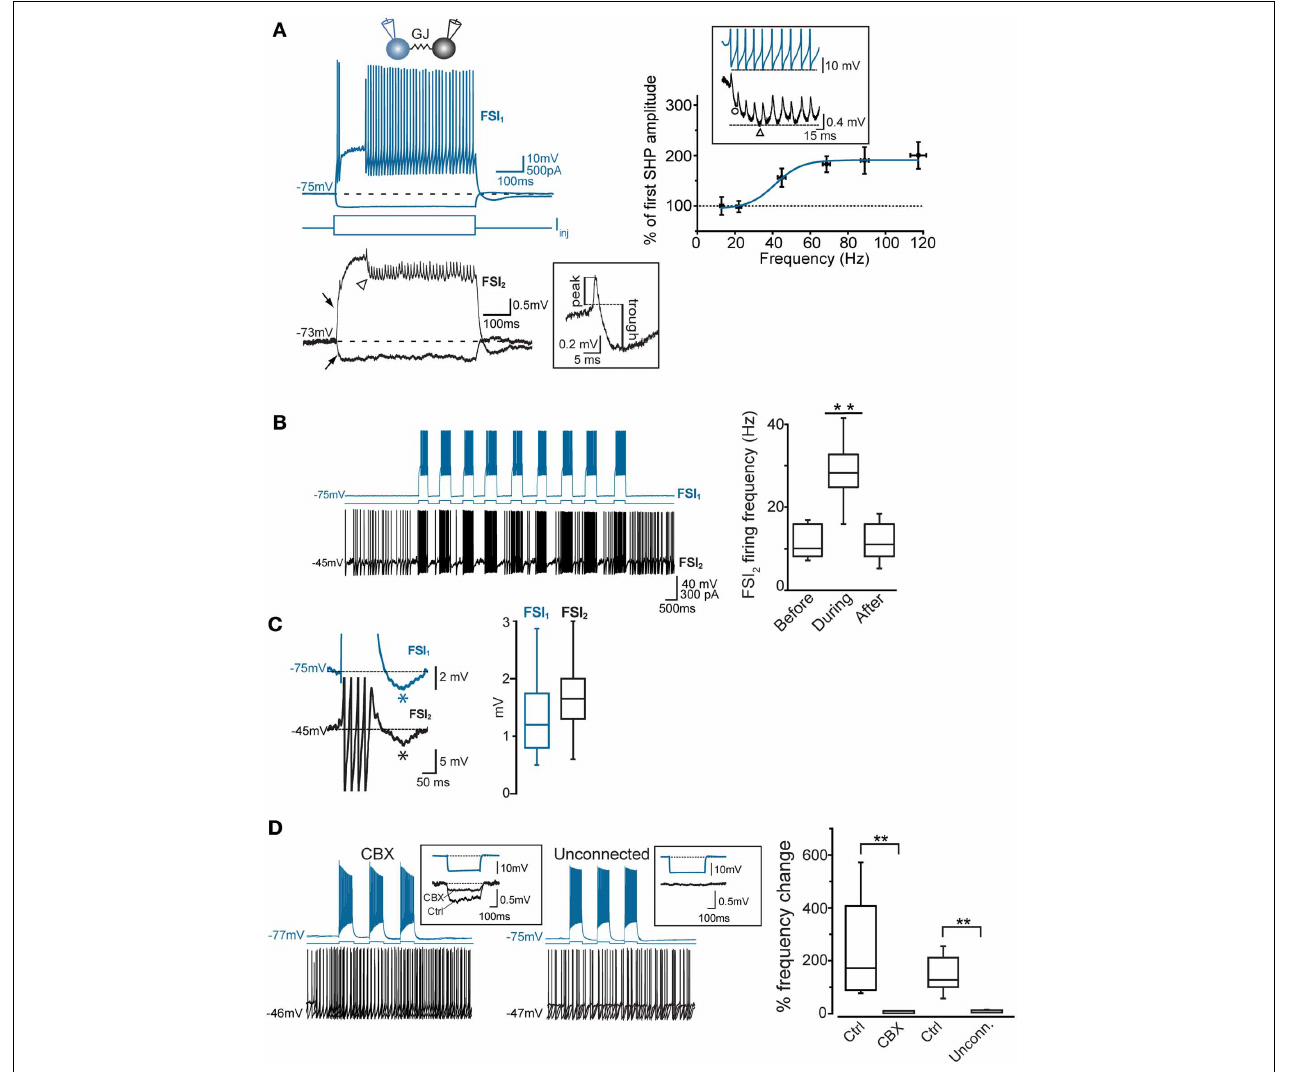
inset). (B) Left, example of transient, repetitive firing entrainment of two electrically connected FSIs (see text for details). Right, summary of average postsynaptic firing frequencies before, during, and after the injection of current pulses in FSI 1 ( n = 48 pairs, ∗∗ p < 0 . 01, paired-sample t -test). (C) Left, magnified view of individual burst events occurring in two FSIs in response to a suprathreshold current pulse injected in FSI 1 . Action potential firing was graphically removed in FSI 1 and partially truncated in FSI 2 in order to emphasize after-hyperpolarization (AHP, marked by asterisks). Right, summary box plots of AHP amplitudes in FSI 1 and FSI 2 . (D) Lack of firing co-activation in response to injection of suprathreshold current pulses in FSI 1 (blue) either in the presence of 200 μ M carbenoxolone (CBX) or in unconnected pairs. Insets show V m changes in FSI 2 in response to a hyperpolarizing current pulse ( − 300pA, 500ms) injected in FSI 1 . The box chart on the right shows a statistical summary relative to frequency changes during current injection in FSI 2 in control conditions, after bath application of CBX ( n = 8, ∗∗ p < 0 . 01, paired t -test) and in connected vs. unconnected pairs ( ∗∗ p < 0 . 01, unpaired t -test, n = 12).